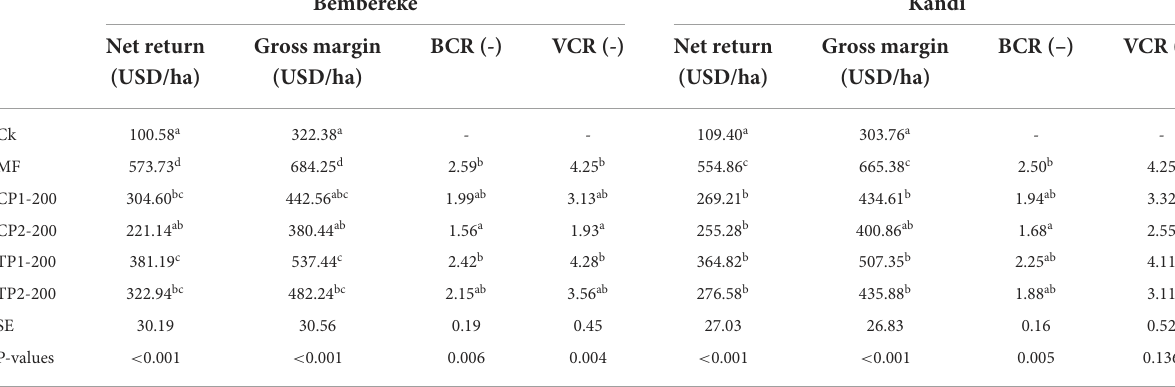
TABLE 7 Effect of biochar-based amendments on economic indicators at two on-farm experimental sites in northern Benin. Bembereke